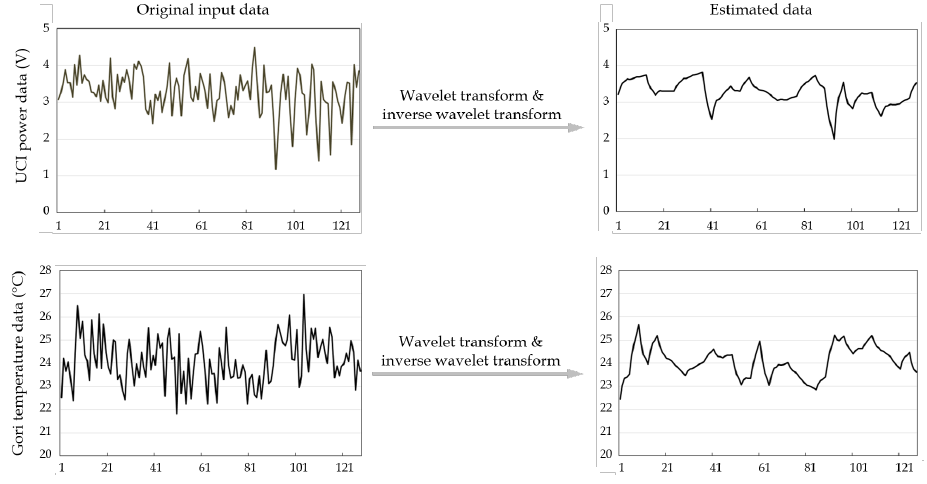
Figure 1. An example of applying wavelet transforms to sensor data.